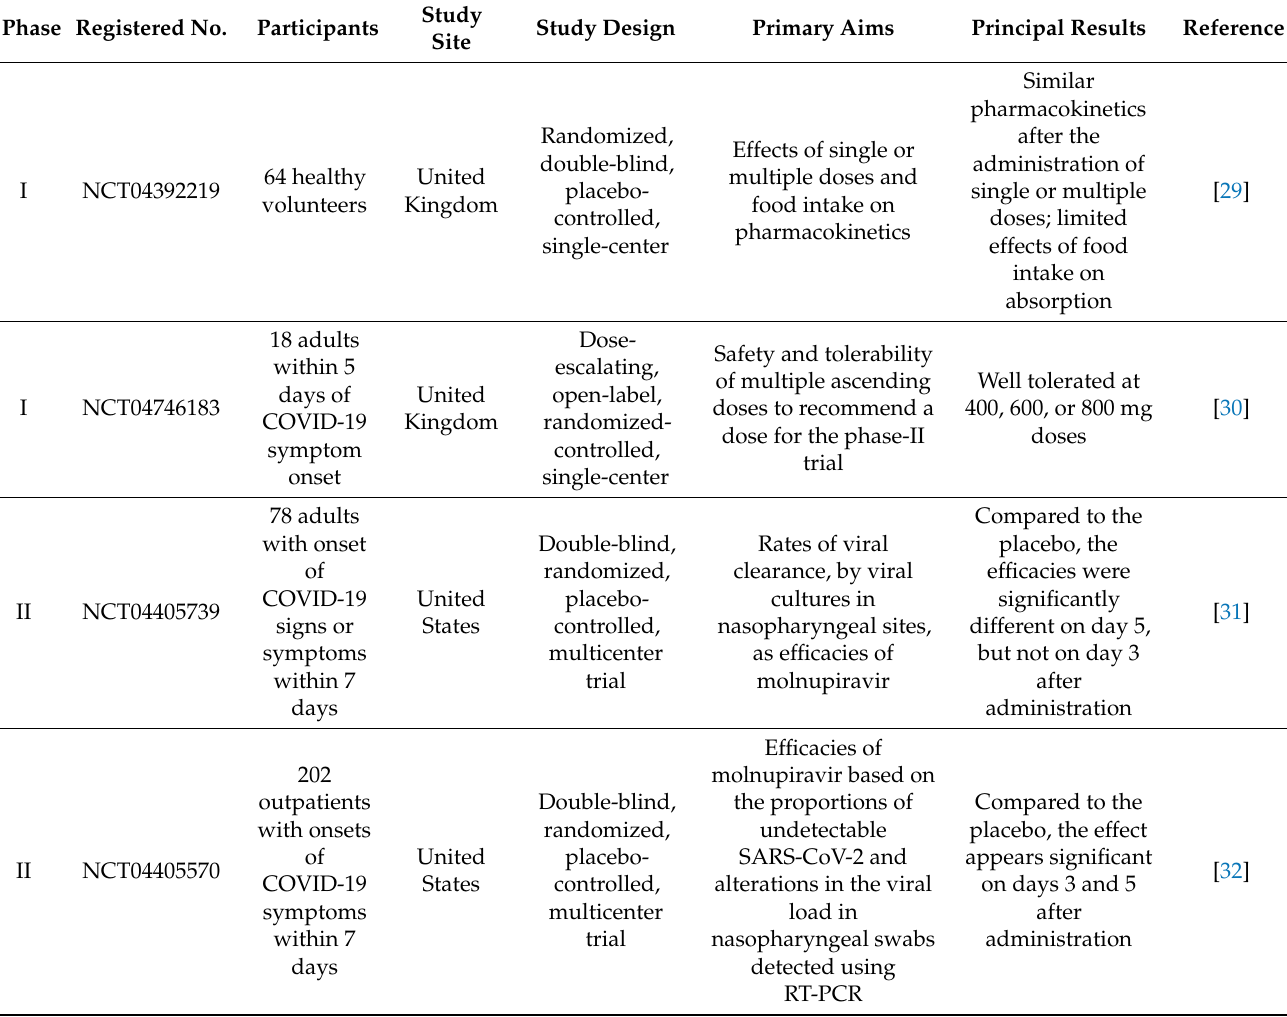
Table 2. Completed clinical phase-I and II trials of